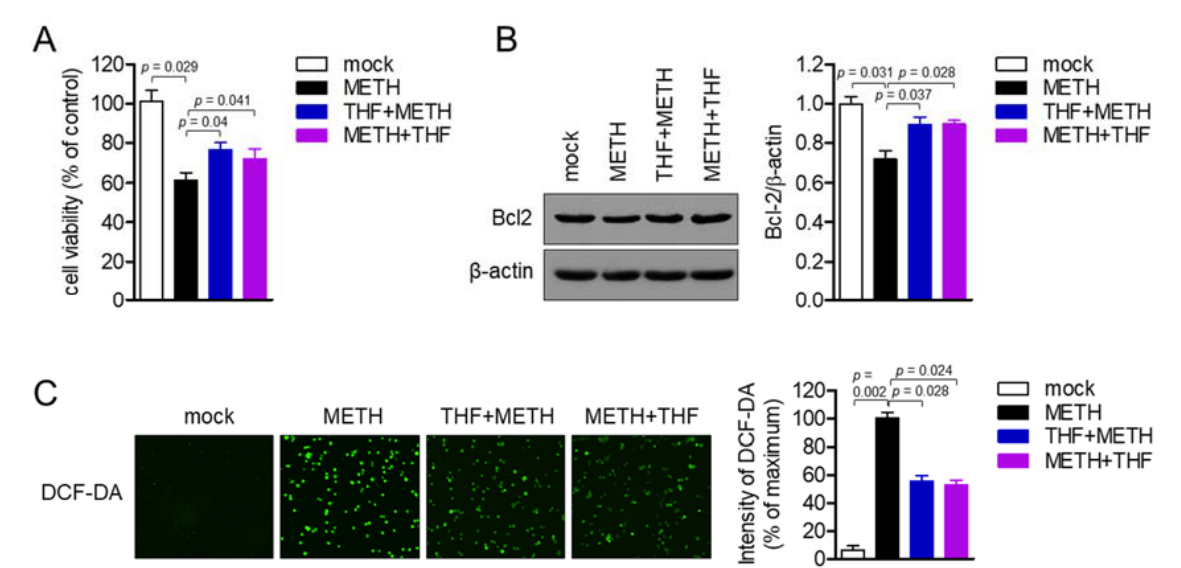
Figure 8. ( A ) SH-SY5y cells (1 × 10 4 /well, 96-well plate) were exposed to the 2 mM of METH for 24 h in the presence of pretreatment with THF or post-treatment with THF. Viability was measured by MTT assay. ( B ) SH-SY5y cells were exposed to the 2 mM of METH for 24 h in the presence of pretreatment with THF or post-treatment with THF. The level of Bcl-2 and β –actin was detected by western blot. Normalization was performed with the expression of Bcl-2 and presented in bar graph. ( C ) SH-SY5y cells (1 × 10 4 /well, 96-well plate) were exposed to 2 mM of METH for 24 h in the presence of pretreatment with THF or post-treatment with THF. Stained cells with 2 μ M 2 ′ ,7 ′ -dichlorofluorescin diacetate (DCF-DA) for 20 min were scanned to detect the production of reactive oxygen species (ROS) using the IncuCyte imaging system. The representative images were obtained and the intensity of DCF-DA was calculated as the percentage of the maximum. Results are shown as the mean value of three experiments ± SEM. p value between two indicated groups.